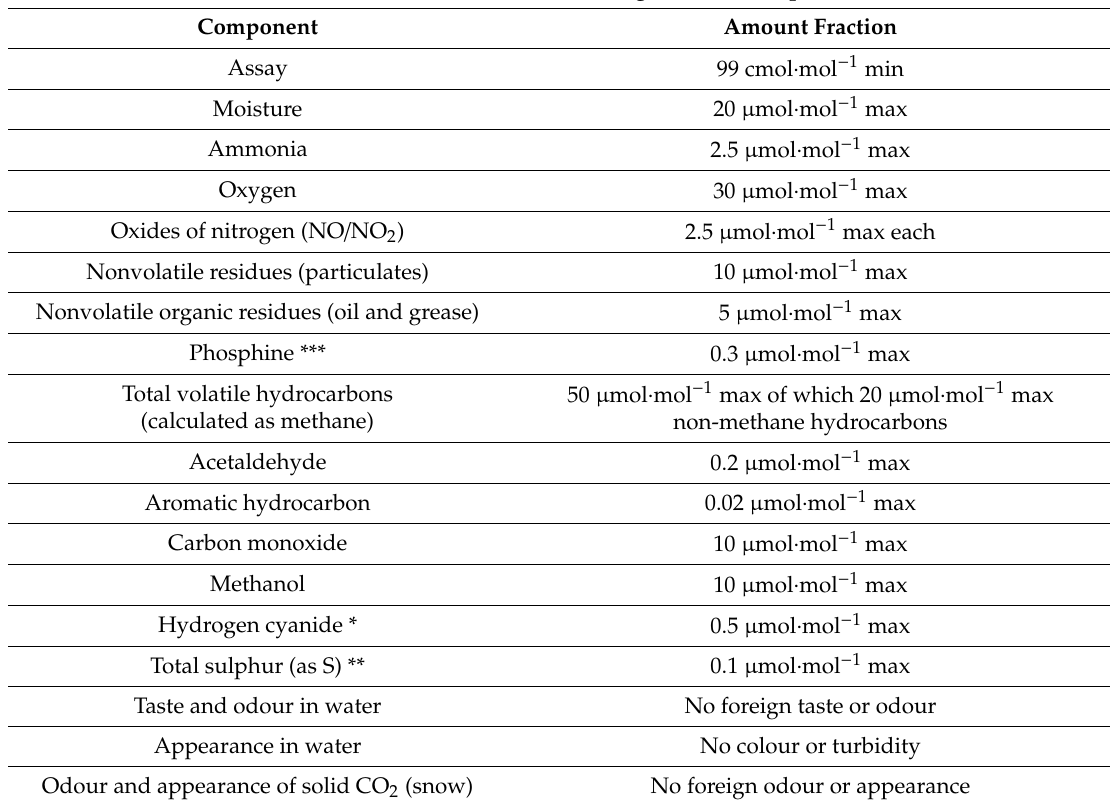
Table 3. Purity specifications for carbon dioxide using in beverage provided by European Industrial Gases Association (EIGA) document 70 / 17.